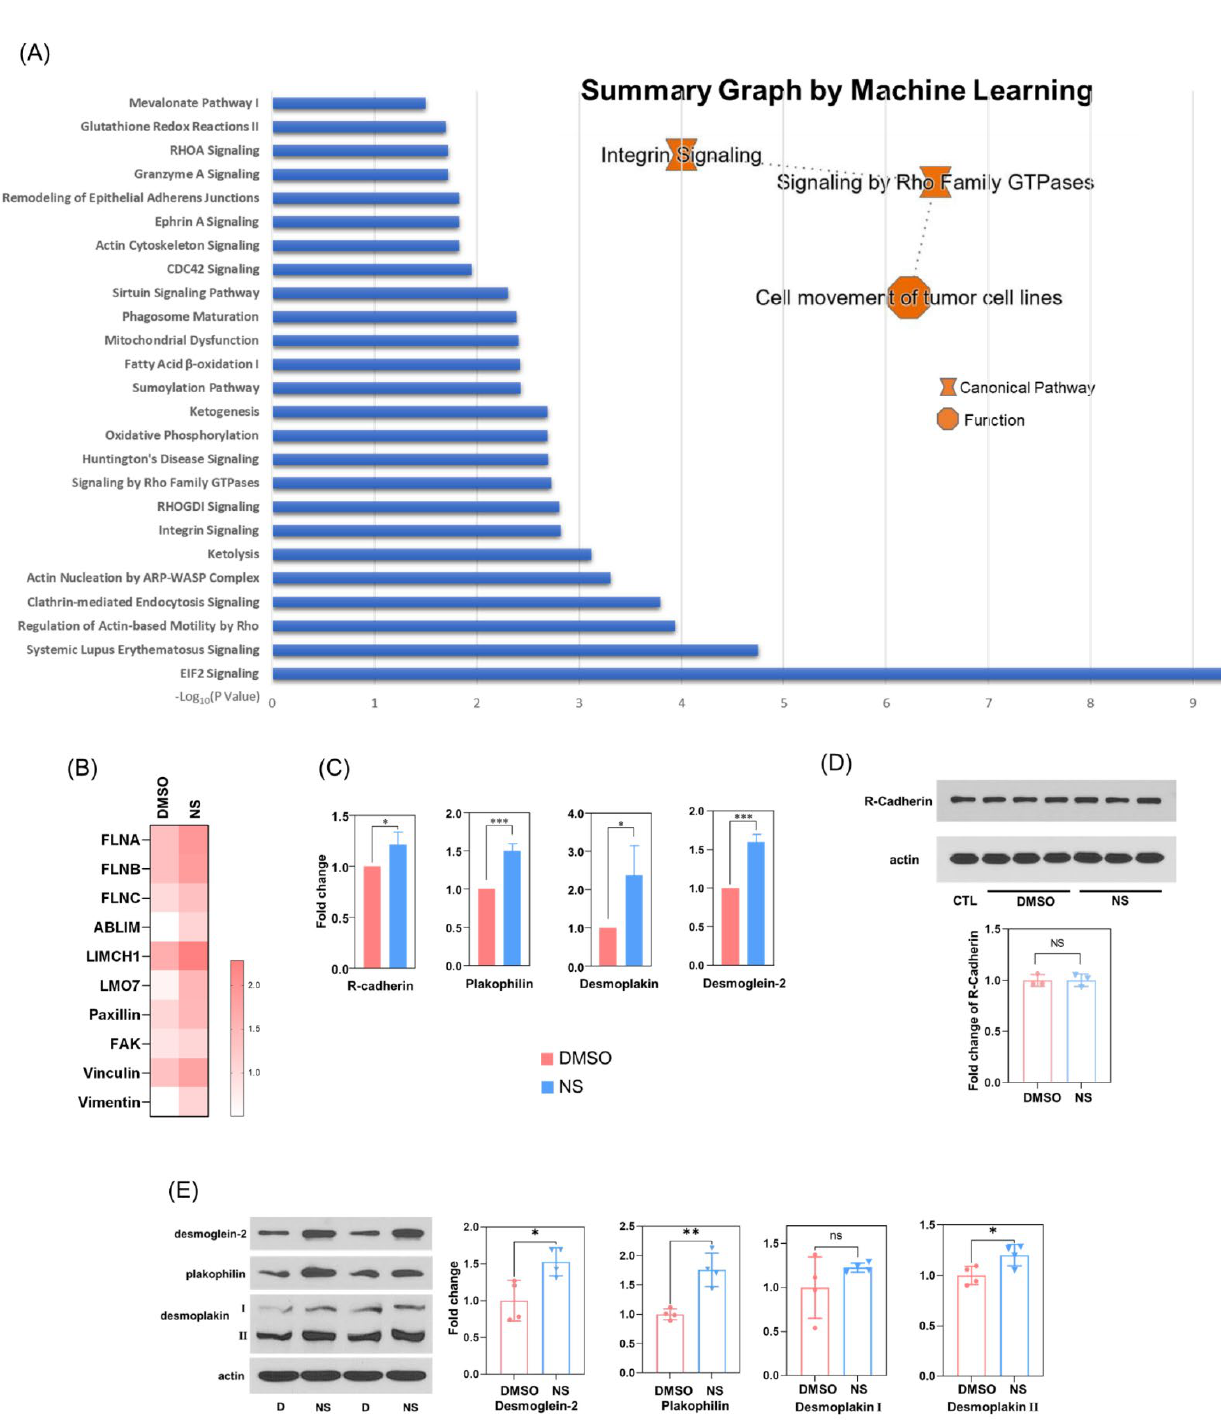
Figure 6. Kv11.1 activation promotes β -catenin interaction with R-cadherin at sites of cell–cell contact. ( A ) MDA-MB-231 cells treated with DMSO or 50 µ M NS1643 for 48 h were lysed and immunoprecipitated with an anti- β -catenin antibody covalently conjugated with magnetic beads. The pellets were washed, eluted, and labeled with TMT6plex Isobaric Label Reagent Set (as Table S1). Labeled samples were analyzed via mass spectrometry. Protein intensity was normalized to β -catenin intensity. Data were processed using Ingenuity Pathway Analysis (IPA) and a summary graph was generated using machine learning prediction. ( B ) Heat map of cytoskeleton-associated proteins calculated from the results of TMT labeling proteomics. Association of 11 proteins with β -catenin, which include actin crosslinking proteins and those associated with focal adhesion complexes increased in cells